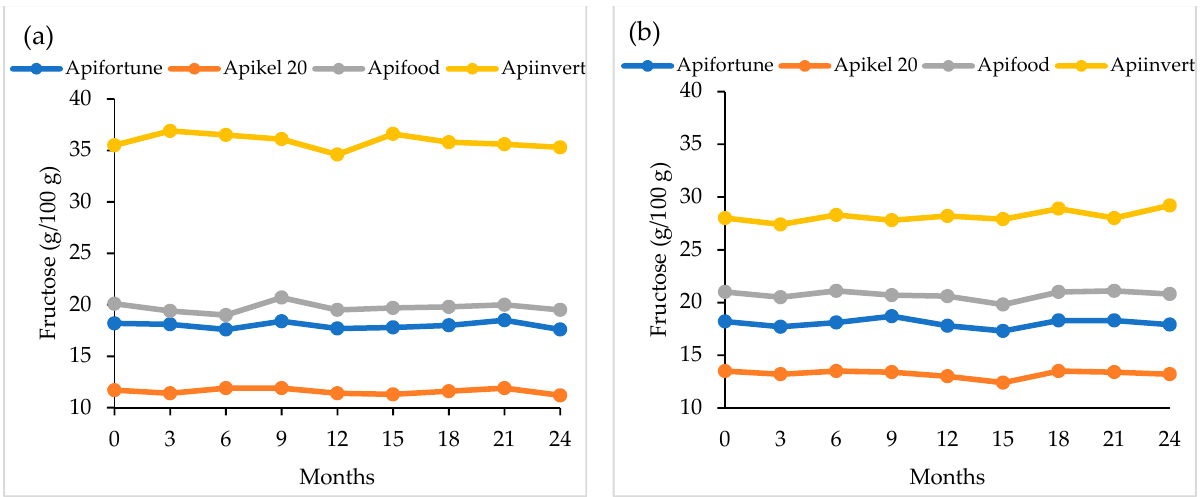
Figure 6. Changes of fructose content in syrups during storage at about 4 °C ( a ) from 2012 and ( b ) from 2013.